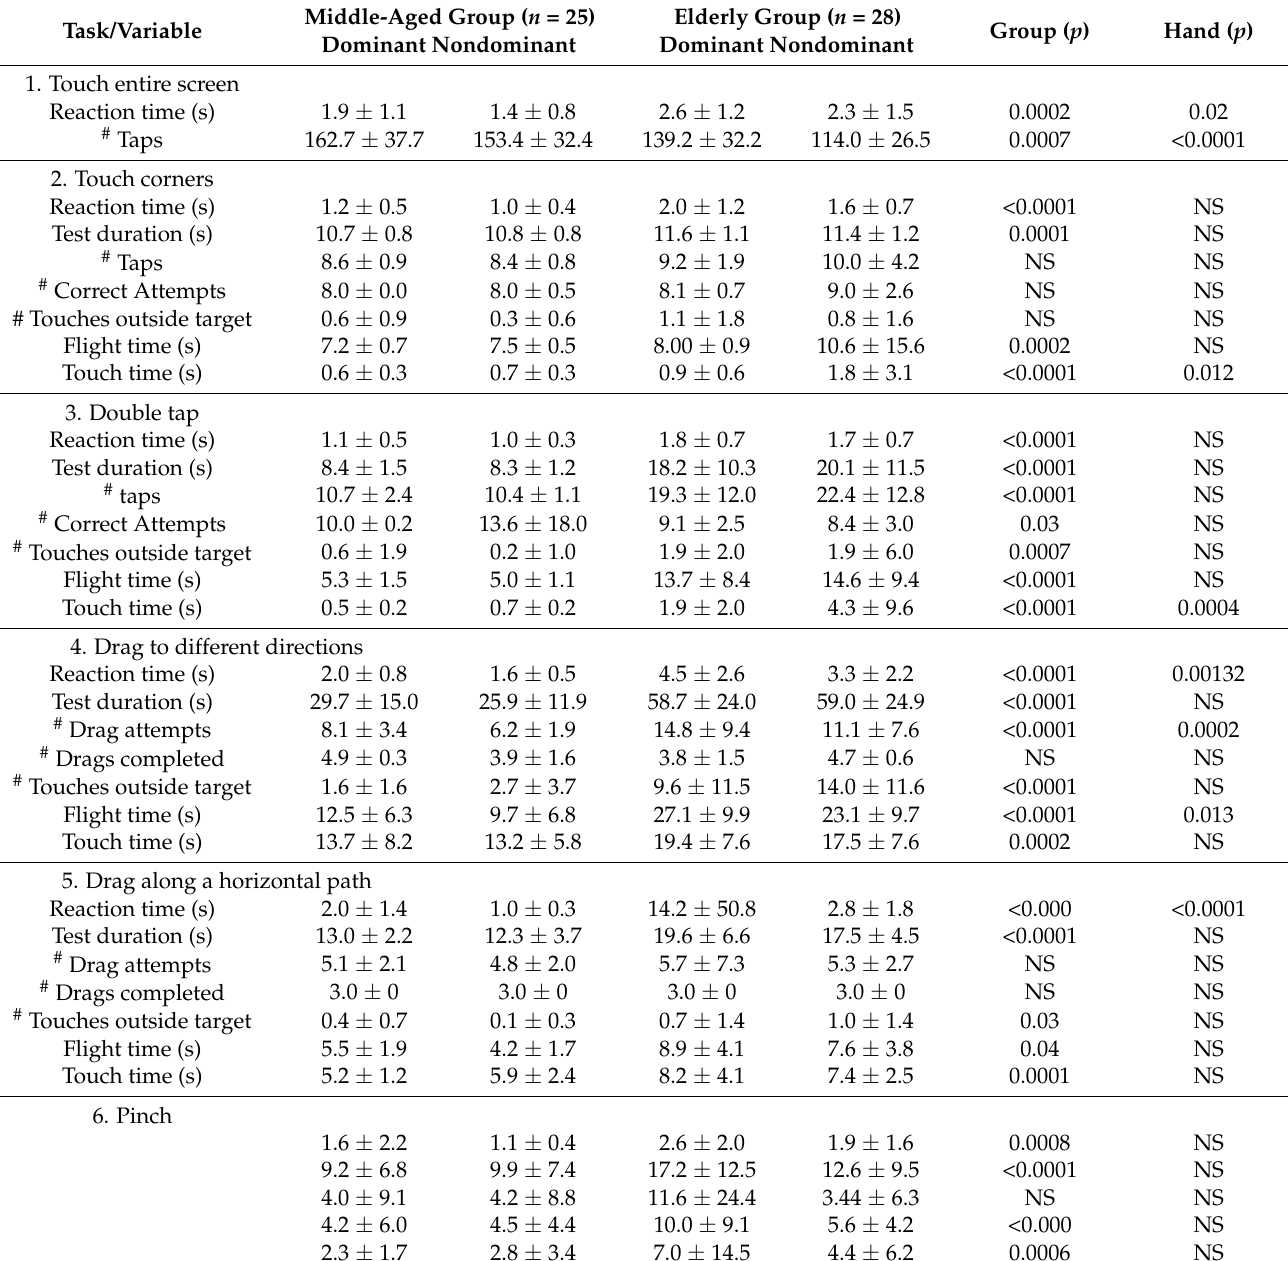
Table 2. Comparison of the Touchscreen Assessment Tool (TATOO) performance between age groups and with respect to hand